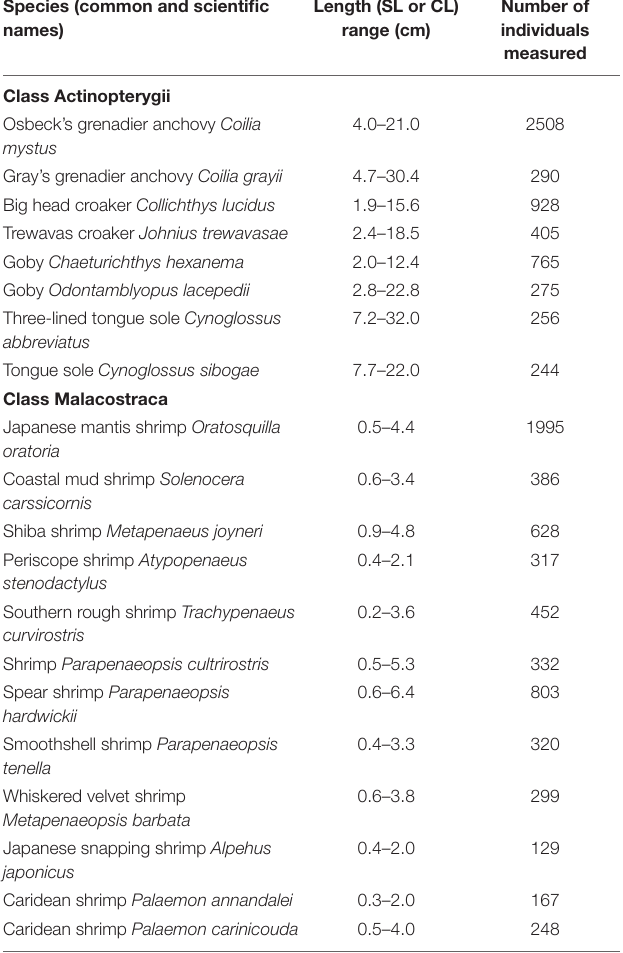
TABLE 1 | Summary of the size range and the number of individuals measured of the 20 fish and shrimp species collected in 2017 and 2018 for stock assessment in the Min River Estuary and its adjacent waters, Fujian Province, southern